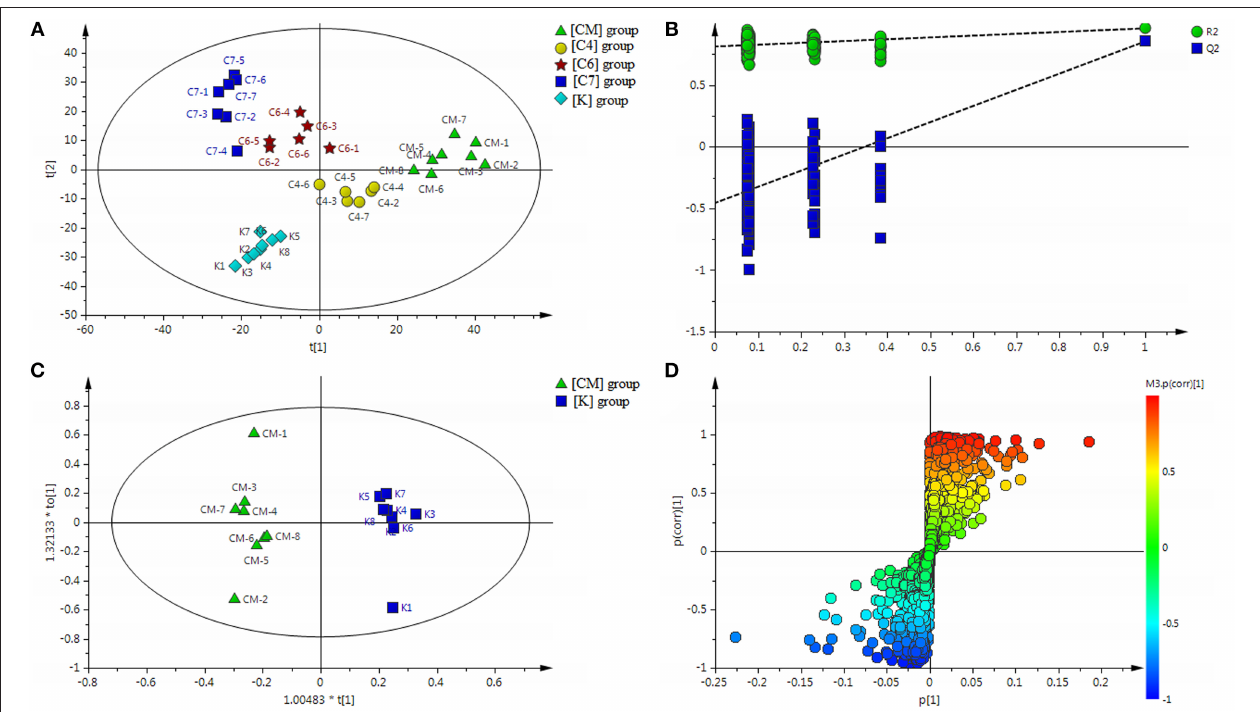
FIGURE 2 | (A) Results of multiple pattern recognition of serum metabolites in CUMS rats with or without exposure to PBR. PLS-DA score plot ( n = 8, R 2 Y = 0.981, R 2 X = 0.531, Q 2 = 0.811). (B) Results of permutation tests. R 2 = 0.802, Q 2 = − 0.498. (C) OPLS score plot ( n = 8, R 2 Y = 0.977, R 2 X = 0.391, Q 2 = 0.873) of [K] group and [CM] group. (D) OPLS S-plot of [K] group and [CM] group. Each triangle in the S-plot represents an ion. Ions far away from the origin were potential biomarkers.